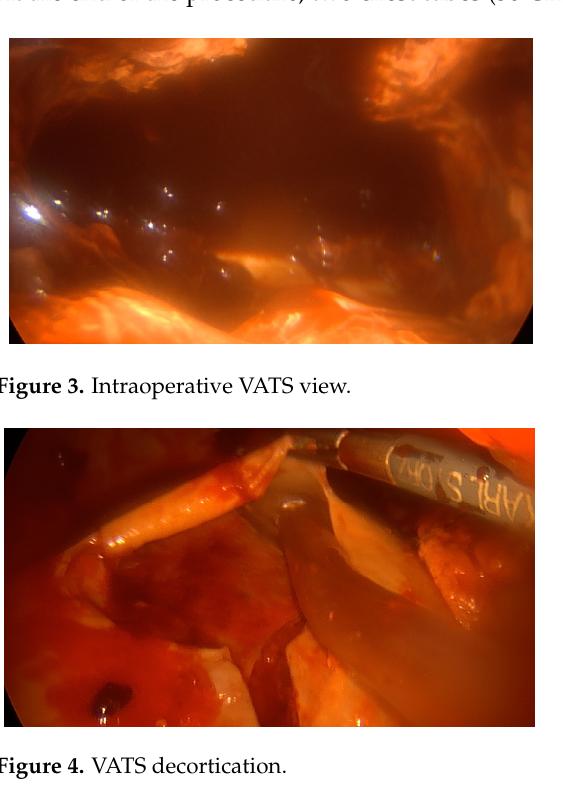
Table 1. Preoperative patients’ characteristics.